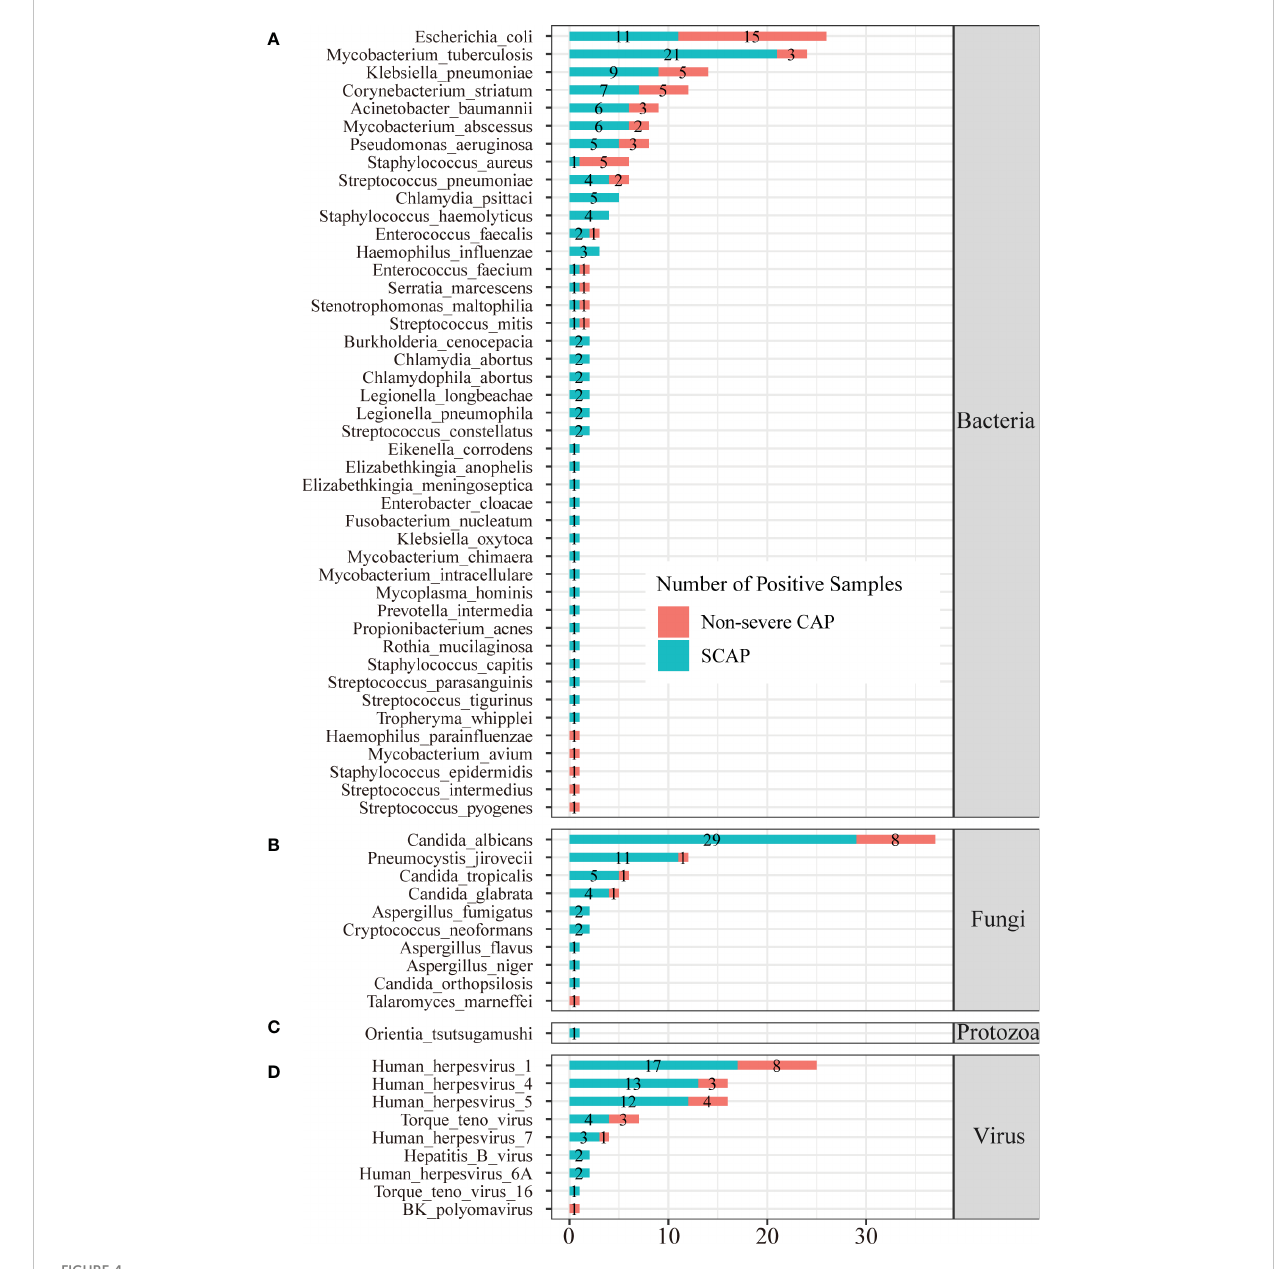
FIGURE 4 Infected pathogens detected by mNGS in severe and non-severe patients with CAP. (A) bacteria levels; (B) fungi level; (C) protozoa level; and (D) virus